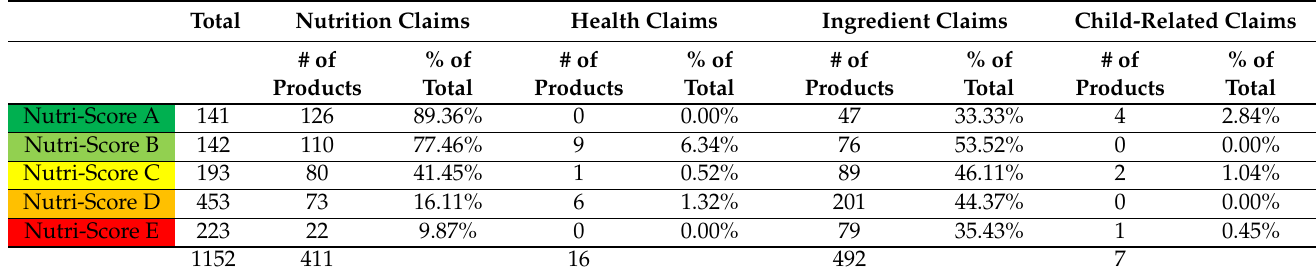
Table 3. Distribution of claims by Nutri-Score